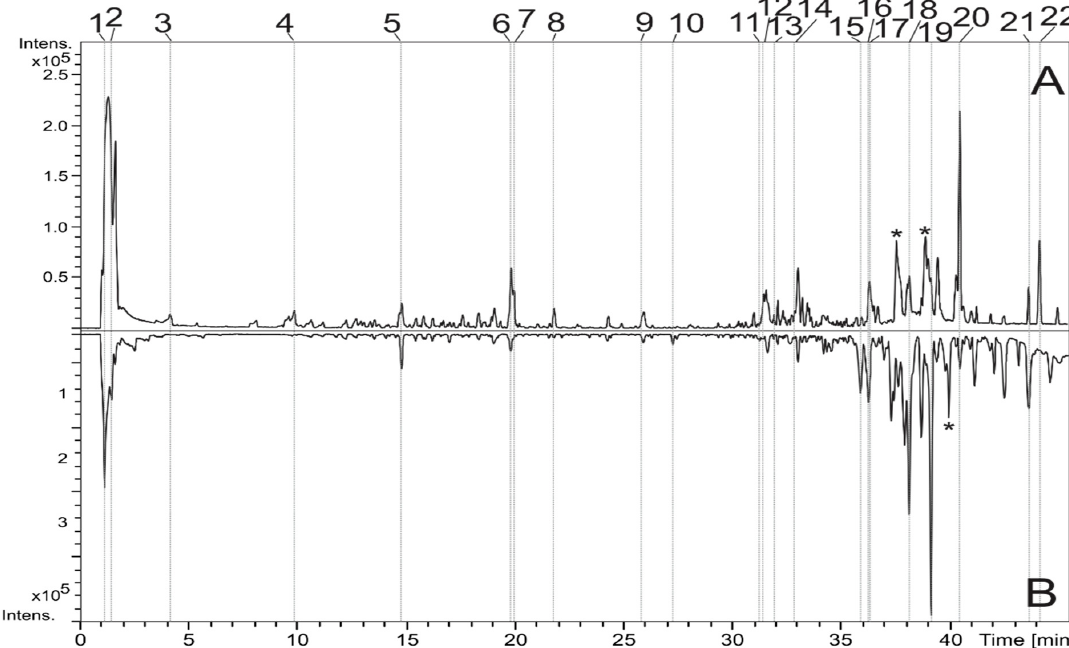
Figure 1. Total ion chromatograms from fruit pulp of D. alata (FPDA) obtained in the negative ( A ) and positive ion mode ( B ) (* peaks are not from the sample). Table 1. Identification of the constituents from fruit pulp of D. alata (FPDA) by LC-DAD-MS / MS. DAD: diode array